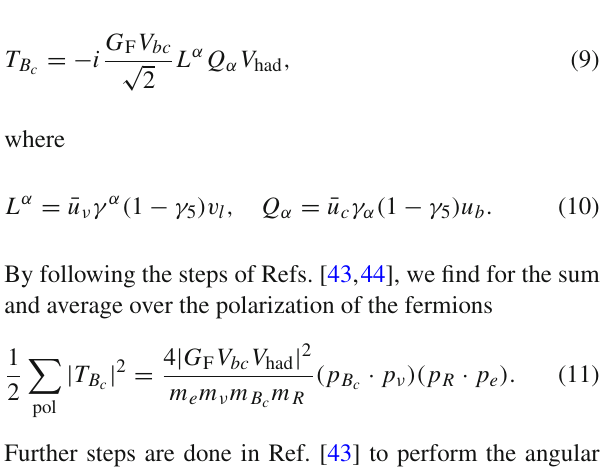
Fig. 3 Diagrams involved in the final state interaction of the primary D ∗ ¯ D ∗ mesons, a tree level, b rescattering